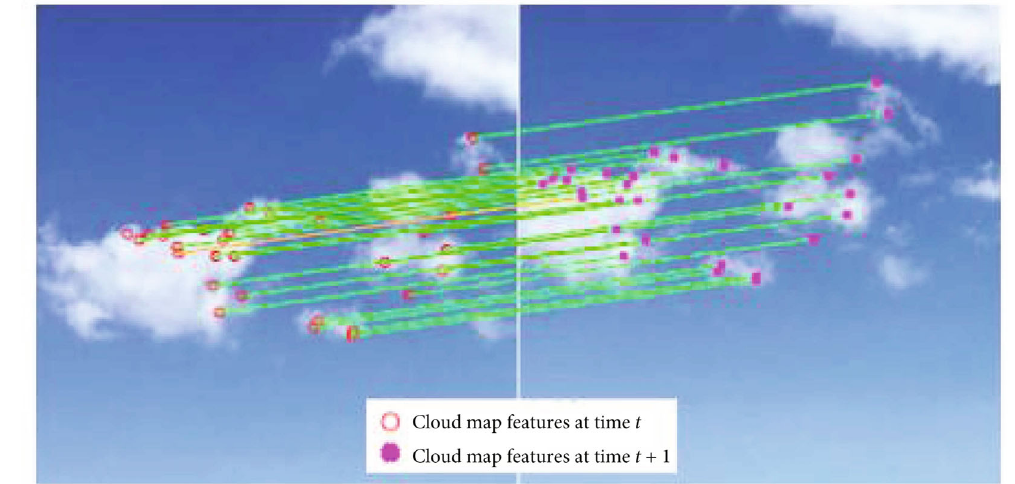
Figure 7: Matching process after optimization.